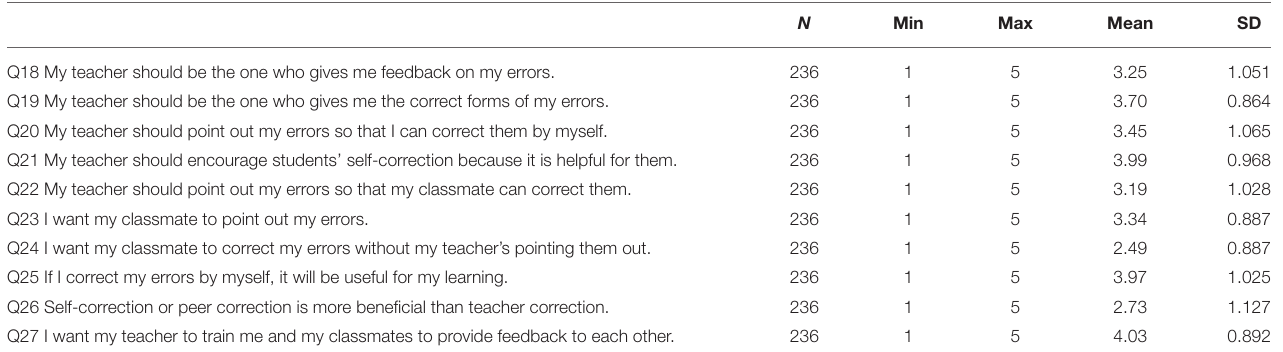
TABLE 2 | Students’ beliefs about the sources of oral corrective